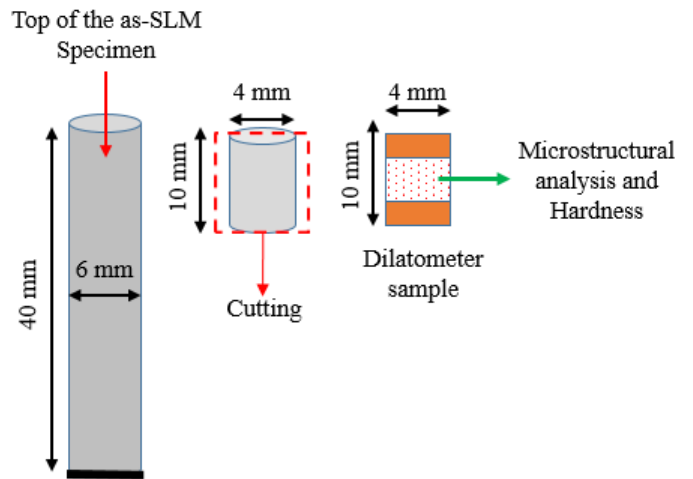
Figure 2. Schematic of dilatometer samples and their designated location for microstructural analysis and micro-hardness measurements.